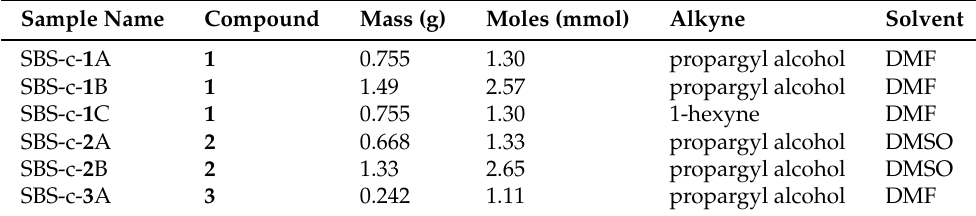
Scheme 4. Synthesis of the polyelectrolytes via click chemistry. Table 1. Ratios of reagents for the synthesis of